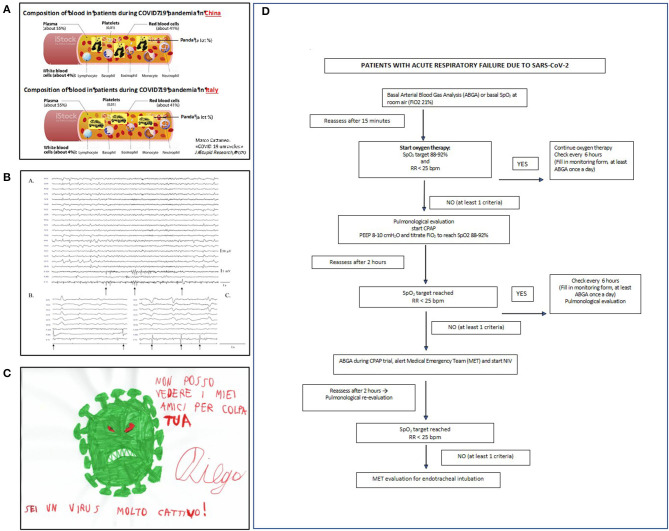
(A) An “alternative” pathophysiological hypothesis for Covid-19 pandemia developed at the department of internal medicine. Amusing moments helped staff to face the disaster (modified from https://www.news-medical.net/health/Blood-Plasma-Components-and-Function-(Italian).aspx). (B) (a) Some Covid-19 patients had myoclonus with a typical electroencephalographic (EEG) pattern showing both periodic lateralized epileptiform discharges (PLEDs) and bilateral PLEDs (bi-PLEDs), predominantly involving the left hemisphere, mainly recorded in the parasagittal and midline regions. (b,c) Black arrows indicate myoclonic jerks, without any correlation with periodic lateralized discharges, nor with a prominent proximal-to-distal gradient of appearance (surface electromyography recorded from the right sternocleidomastoid, extensor carpi radialis longus, and tibialis anterior muscles). (C) The virus as seen by an autistic child aged 8. In children with psychiatric disorders, Covid-19 remarkably influenced their thought and mood. (D) The algorithm for ventilation used in our patients (PEEP, positive end-expiratory pressure; SpO2, pulse oximetry; FiO2, fractional inspiration of oxygen; NiV, non-invasive ventilation; CPAP, continuous positive airway pressure).